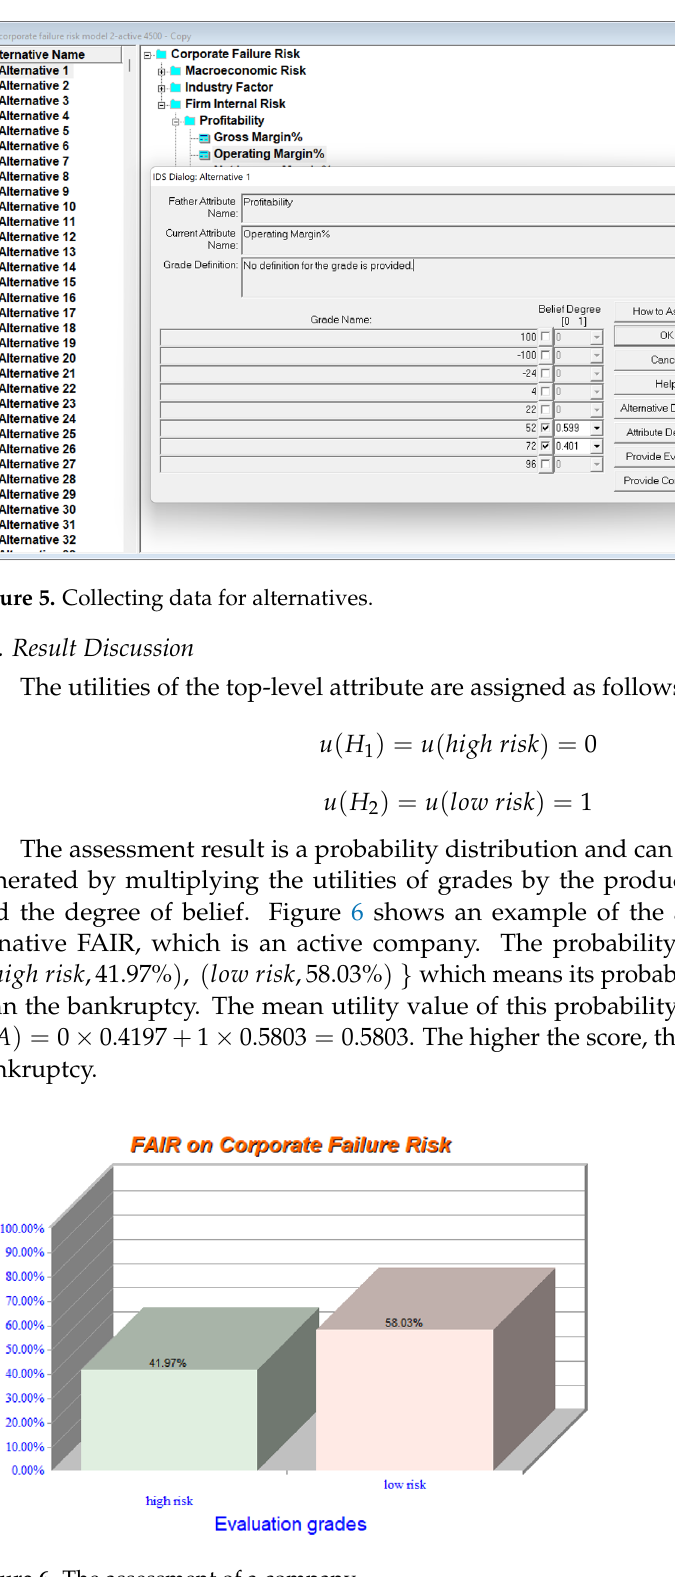
Figure 4. Assigning weights to attributes.